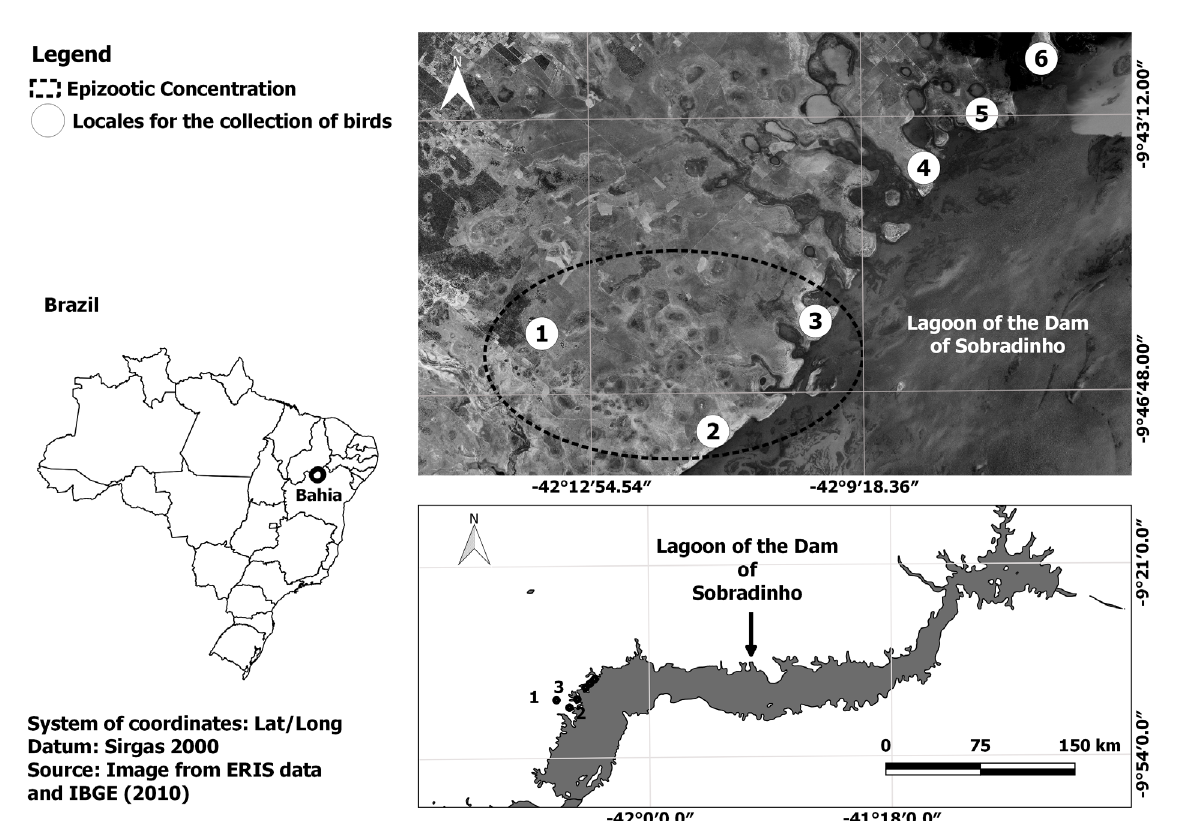
Figure 1. Map of the study area. The black polygon marks the area of concentration of the epizootic episode. In the left, the position of the area within the country and the Caatinga Biome; in the right, a detailed view of the sampling